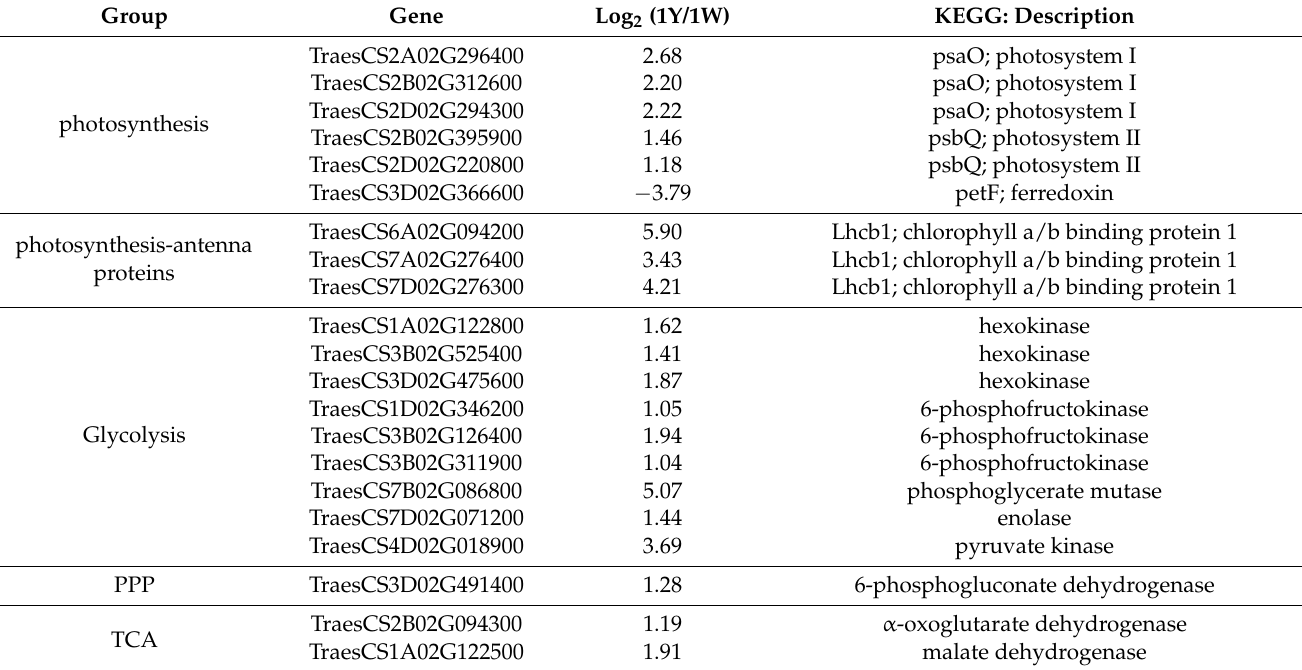
Table 3. Genes encoding enzymes involved in carbon